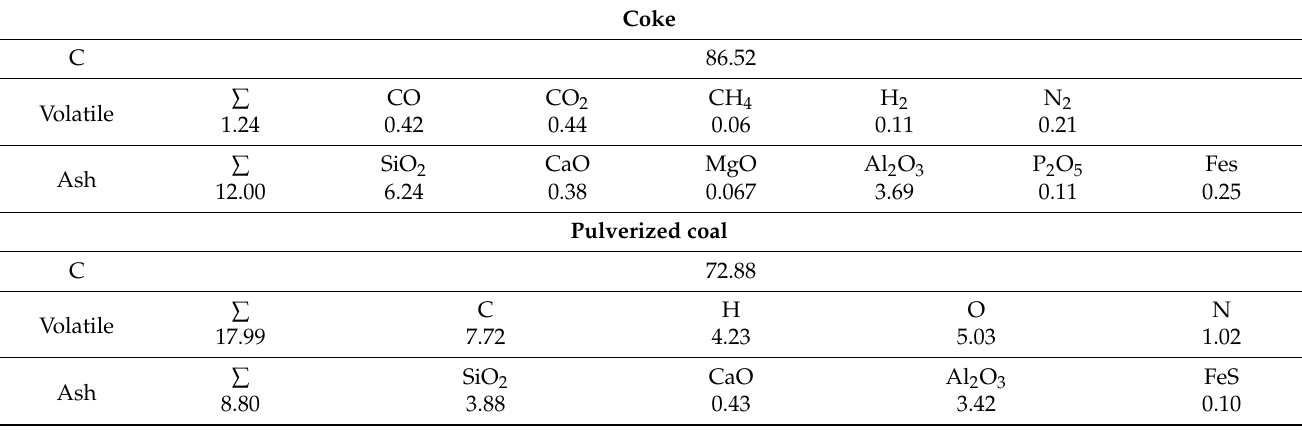
Table 2. Fuel composition (mass fraction)%.